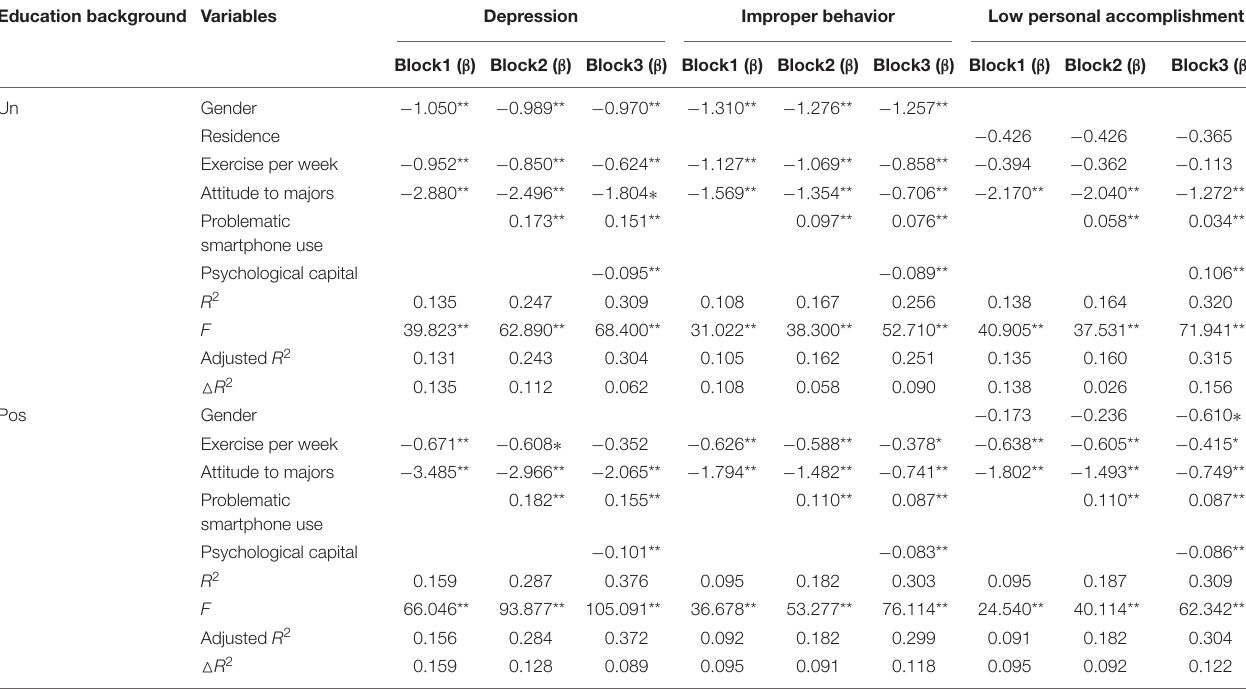
TABLE 4 | The effect of problematic smartphone use and psychological capital on three dimensions of learning burnout. Education background Variables